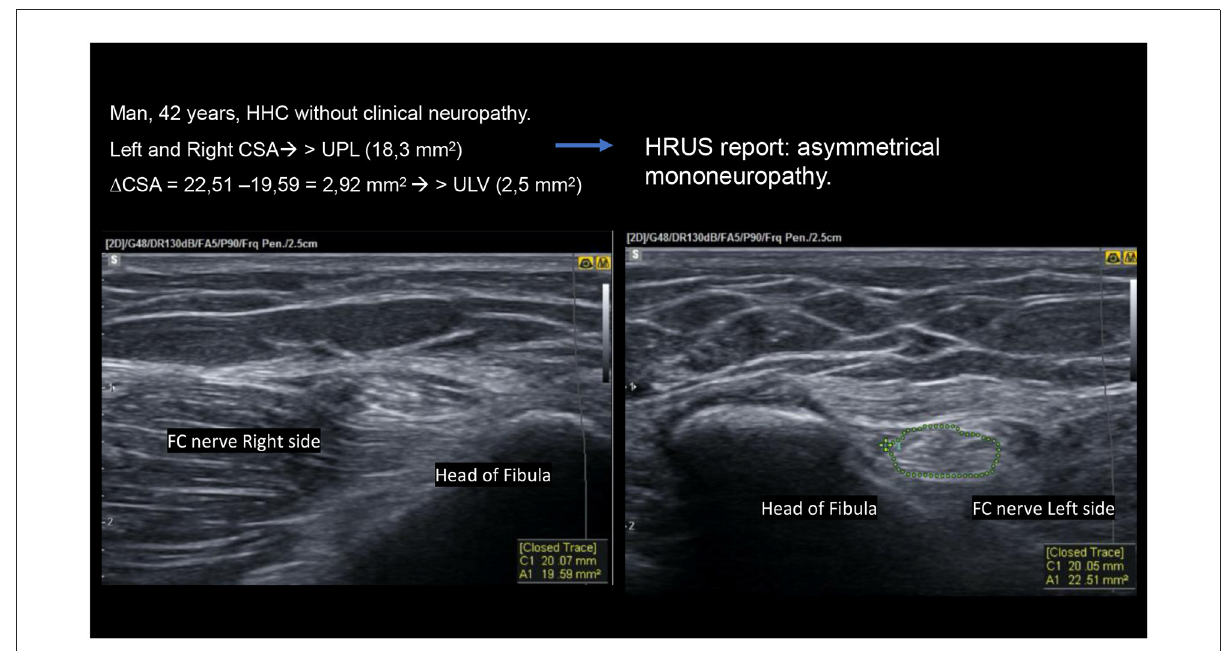
FIGURE8 High-resolution ultrasound (HRUS) images of the same HHC of a patient with HD with asymmetrical mononeuropathy of the common fibular nerve on the head of the fibula.